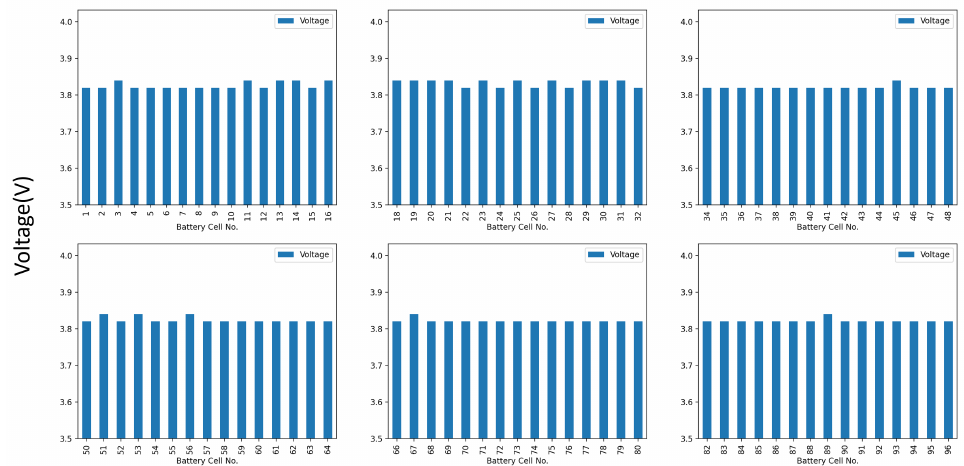
Figure 13. Instantaneous voltages of all 96 battery cells in the Hyundai Ioniq Battery